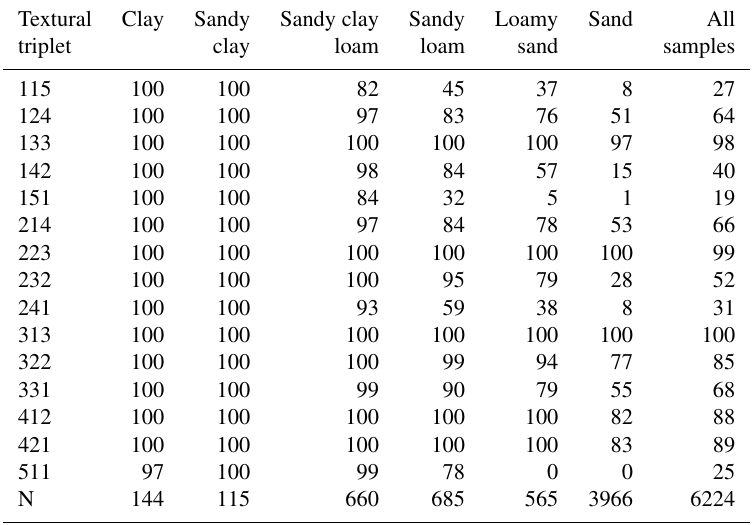
Table 2. Percentage of samples for which simulated and measured particle size distributions are not different at the 0.05 significance level.